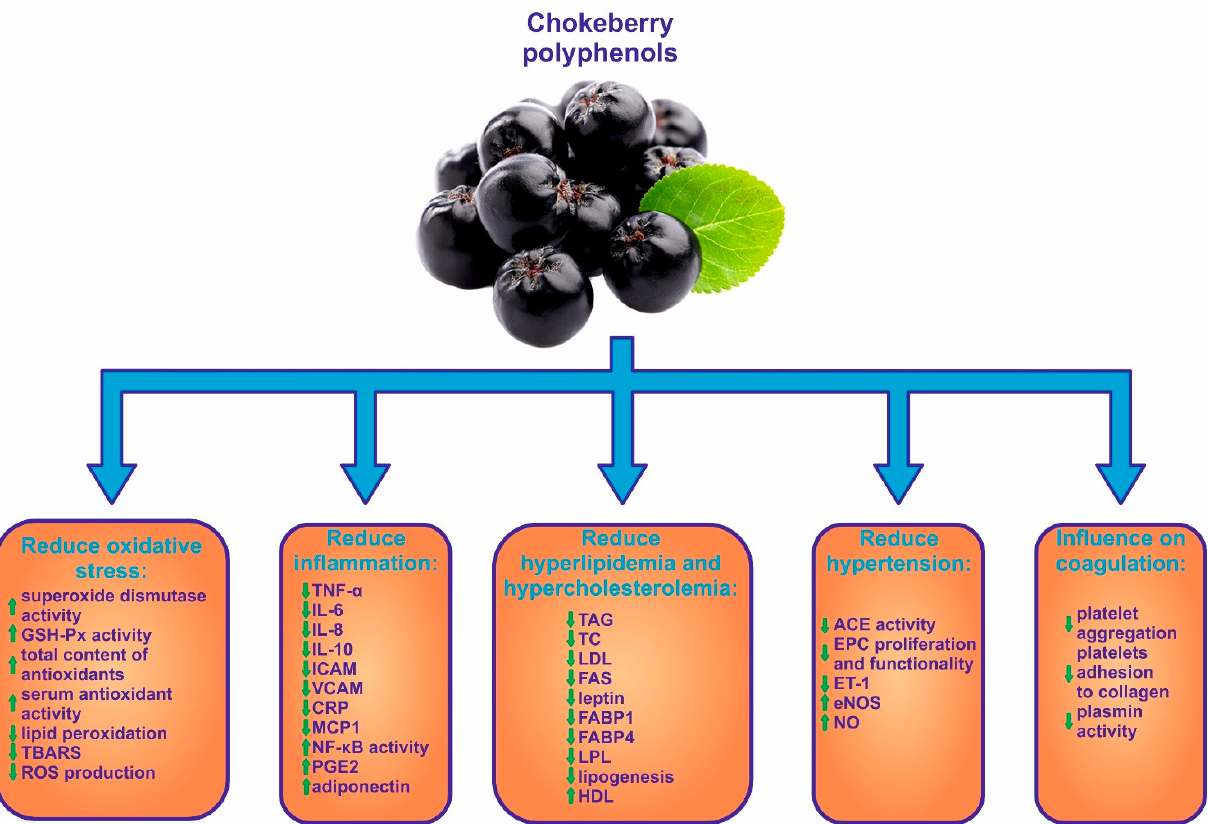
Figure 4. Role of chokeberry fruits in cardiovascular dysfunction. ↑ value increase; ↓ value decrease; ACE: angiotensin converting enzyme, CRP: C-reactive protein, eNOS: endothelial nitric oxide synthase, EPC: endothelial progenitor cells, ET-1: endothelin-1, FABP1: fatty acid binding protein 1, FABP4: fatty acid binding protein 4, FAS: faty acid synthase, GSH-Px: glutathione peroxidase, HDL: high-density lipoprotein cholesterol, ICAM: intercellular adhesion molecule, IL-6: interleukun 6, IL-8: interleukun 8, IL-10: interleukun 10, LDL: low-density lipoprotein cholesterol, LPL: lipoprotein lipase, MCP1: monocyte chemoattractant protein-1, NF- κ B: nuclear factor kappa-light-chain-enhancer of activated B cells, NO: nitric oxide, PGE2: prostaglandin E2, ROS: reactive oxygen species, TAG: triacylglycerol, TBARS: substances reacting with thiobarbituric acid, TC: total cholesterol, TNF- α : tumor necrosis factor- α , VCAM: vascular cell adhesion molecule.